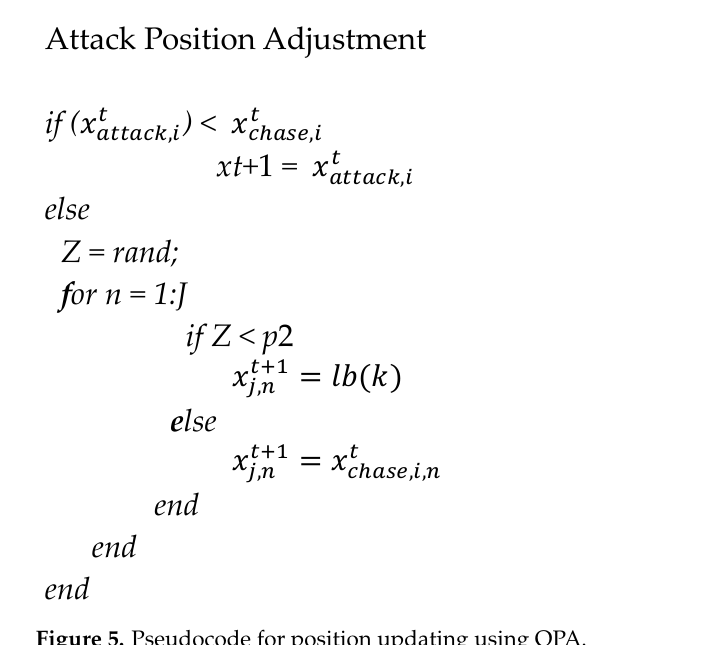
Figure 4. Graphical representation of orcas attacking prey.